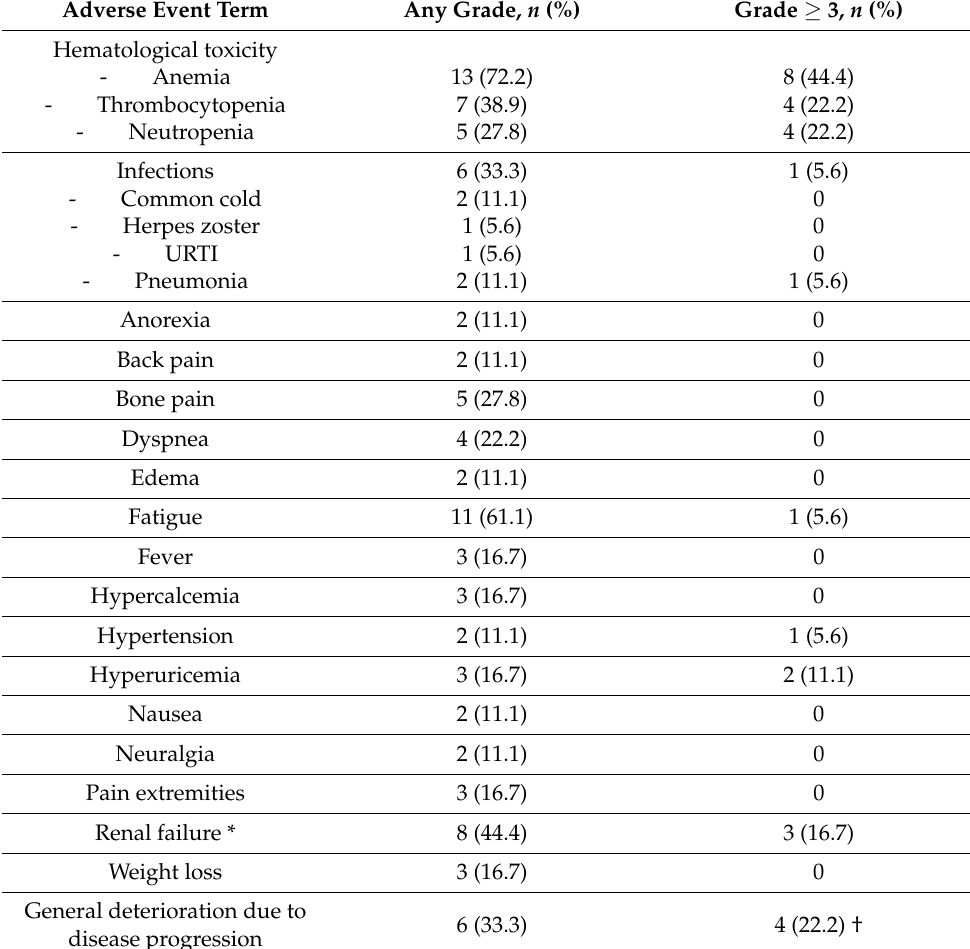
Table 2. Adverse events occurring in more than 1